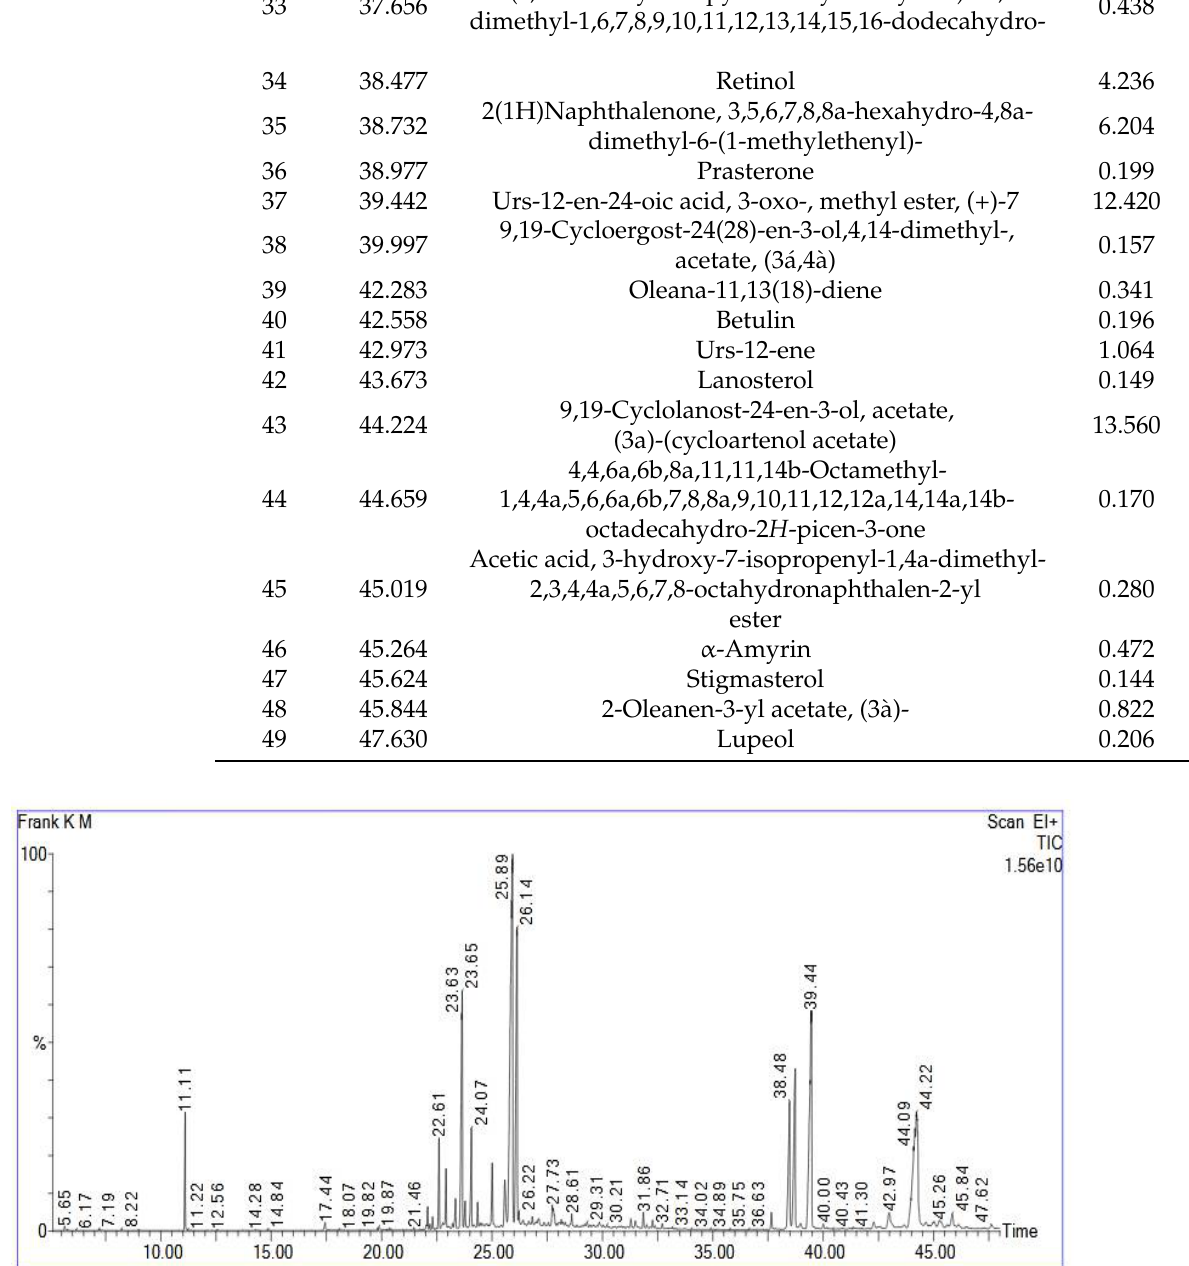
Figure 1. GC/MS total ion chromatogram of the frankincense oleoresin ethanol extract. Table 1. Volatile phytoconstituents identified in the frankincense oleoresin ethanol extract by GC- MS.